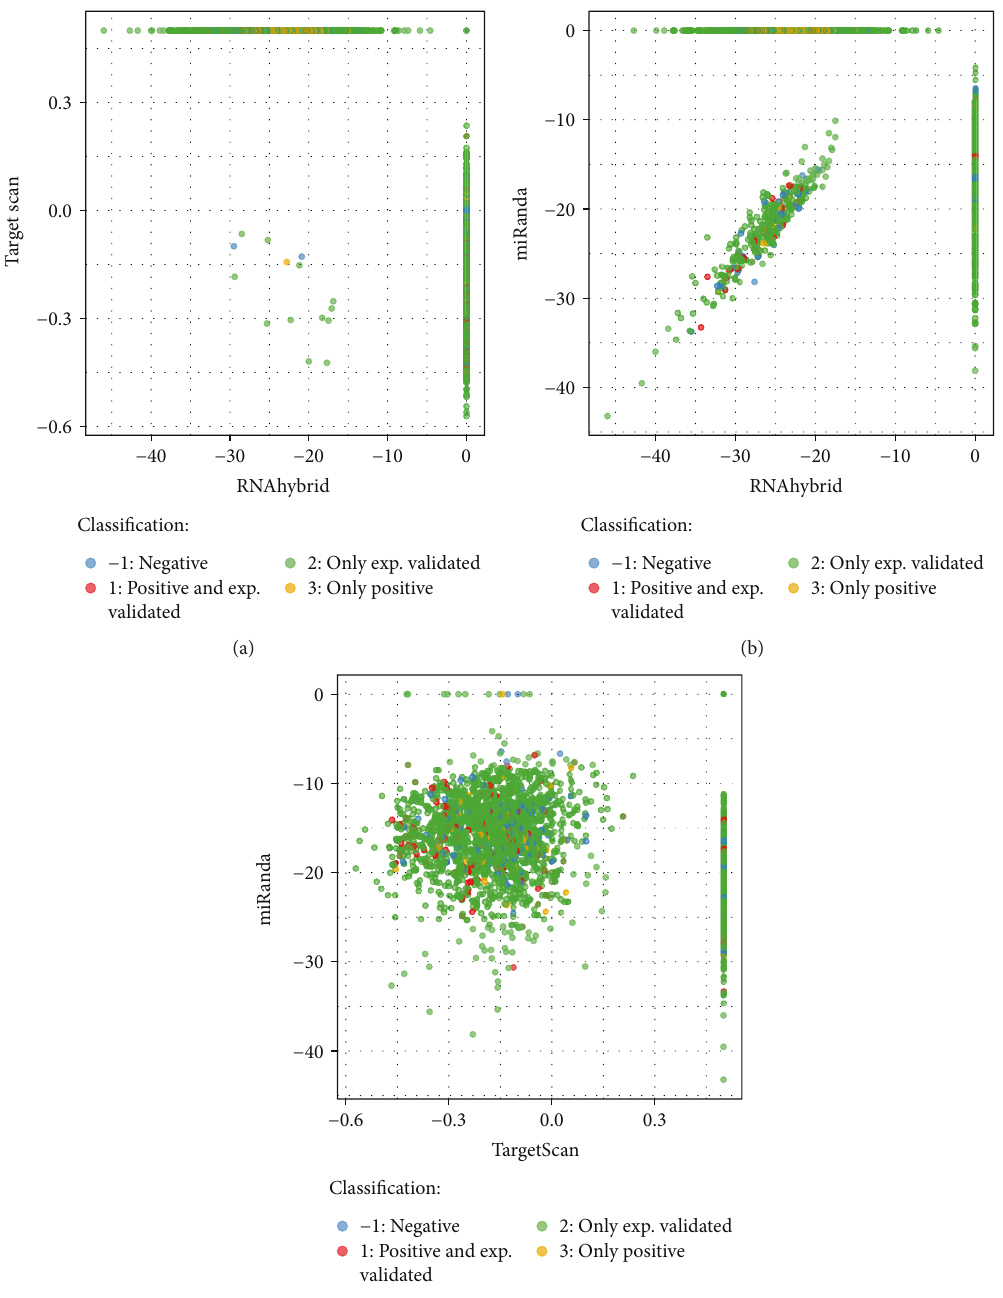
Figure 1: Scatter plots showing the distribution of the data: negative examples are represented by blue dots, while three di ff erent colors are used for positive examples. More precisely, red are those samples that are among the positive examples in the dataset from [29] and that are also experimentally validated, green for those only experimentally validated in miRTarBase, and yellow for the ones that are only in the positive examples of the dataset from